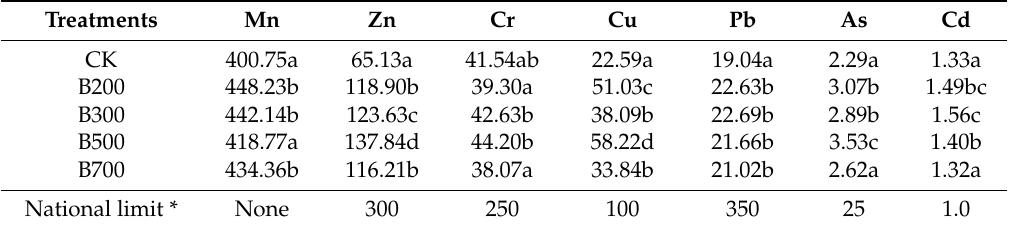
Table 4. Total quantities of the heavy metals in the soils amended with the biochars derived from municipal sewage sludge at 200 ◦ C, 300 ◦ C, 500 ◦ C, and 700 ◦ C for 2 h in a muffle furnace and then grown turf grass (mg kg − 1